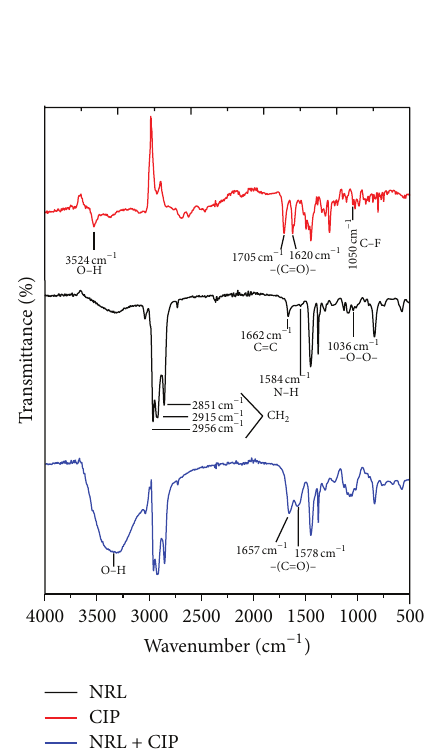
Figure 5: FTIR-ATR spectra of ciprofloxacin, NRL, and NRL loaded with ciprofloxacin.